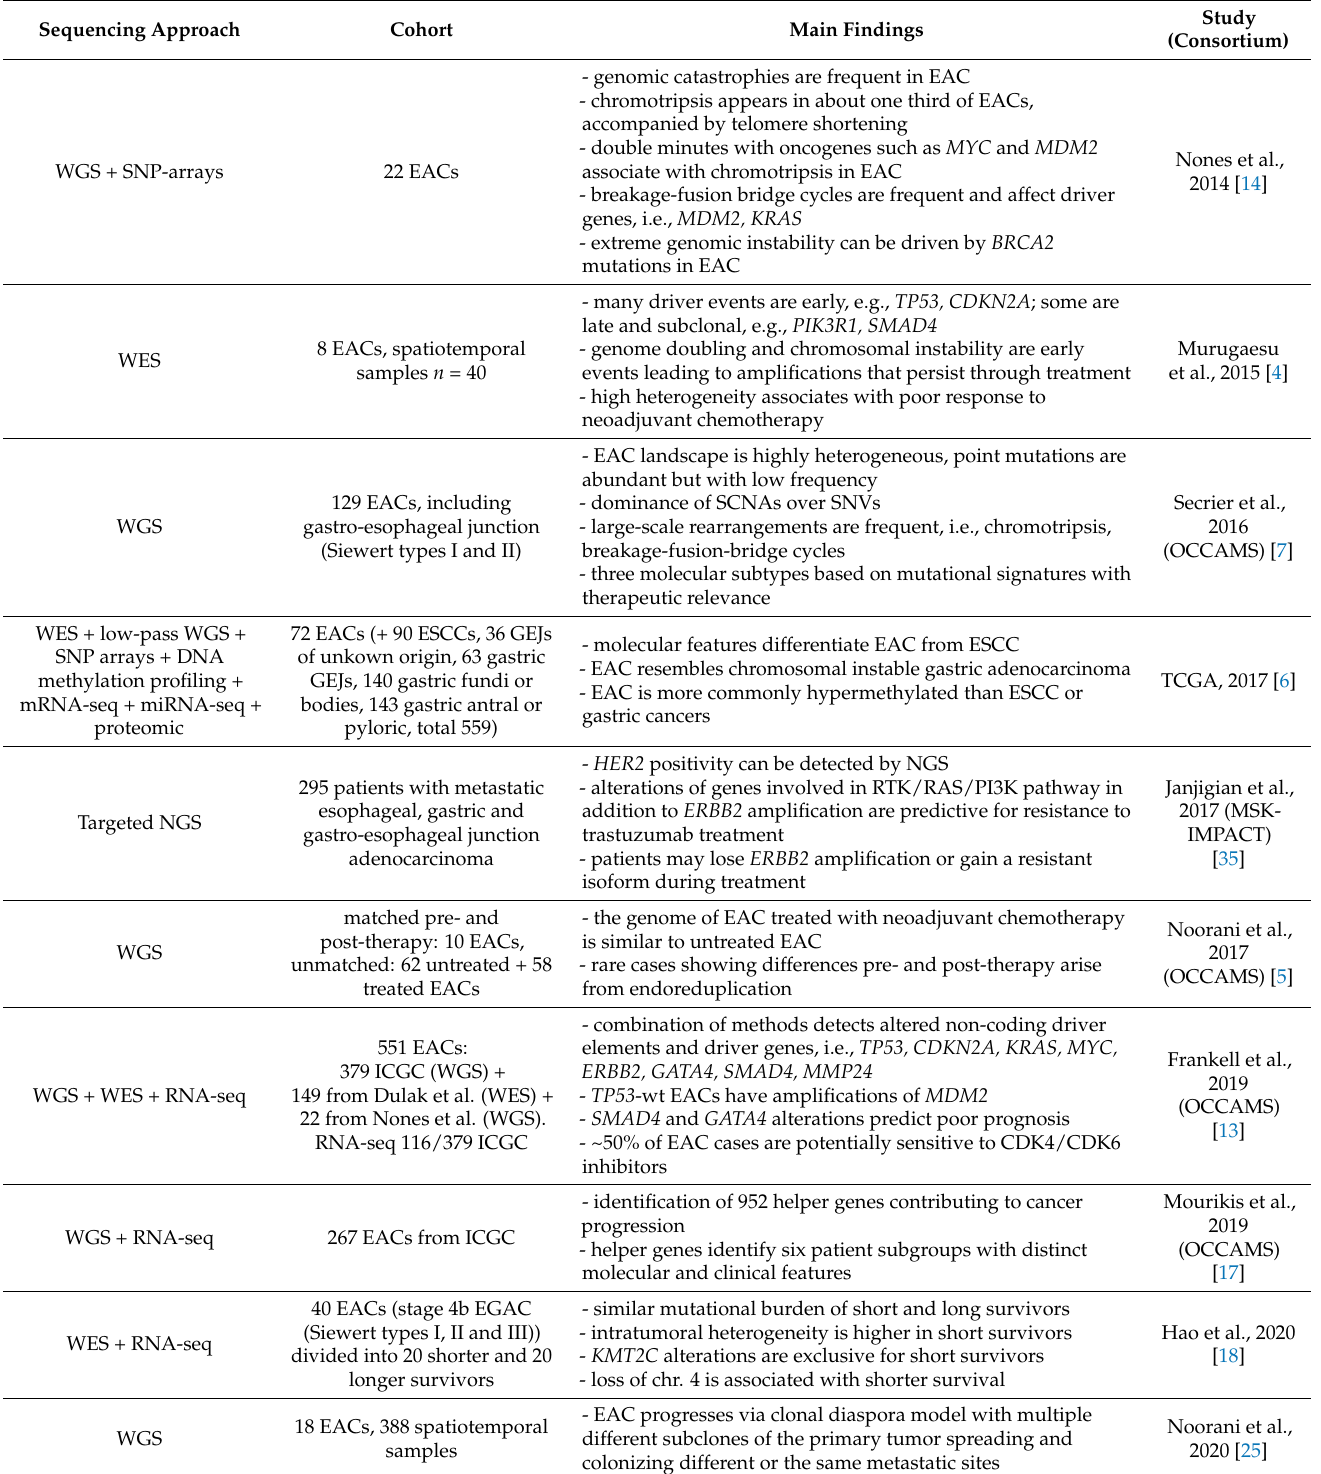
Table 1. Main genome next-generation sequencing studies of